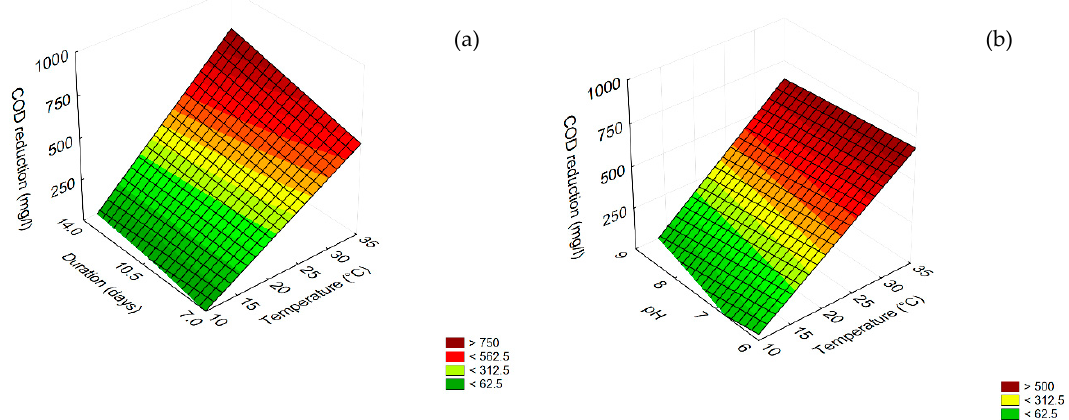
Figure 3. Surface response plots for the interaction temperature / duration ( a ) and temperature / pH ( b ) on COD reduction in diluted TOPW by the combination of B. pumilus – C. boidinii strains.